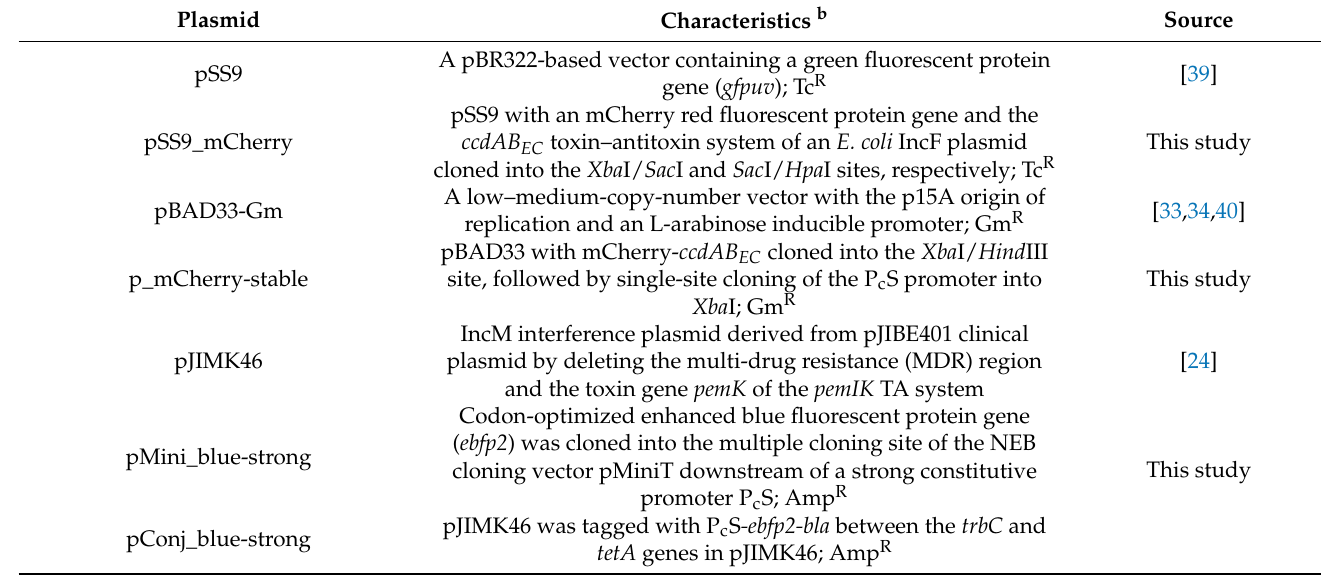
Table 4. Plasmids used in this